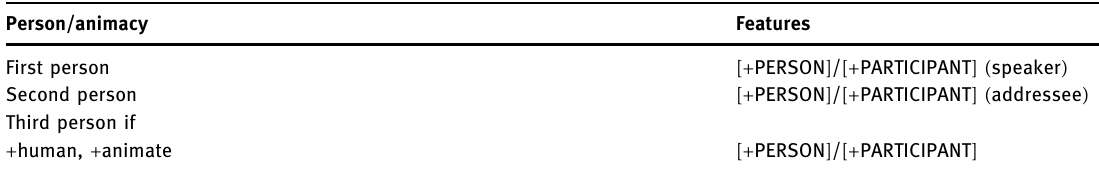
Table 10: Person and animacy ( building on Harley and Ritter 2002, a.o.